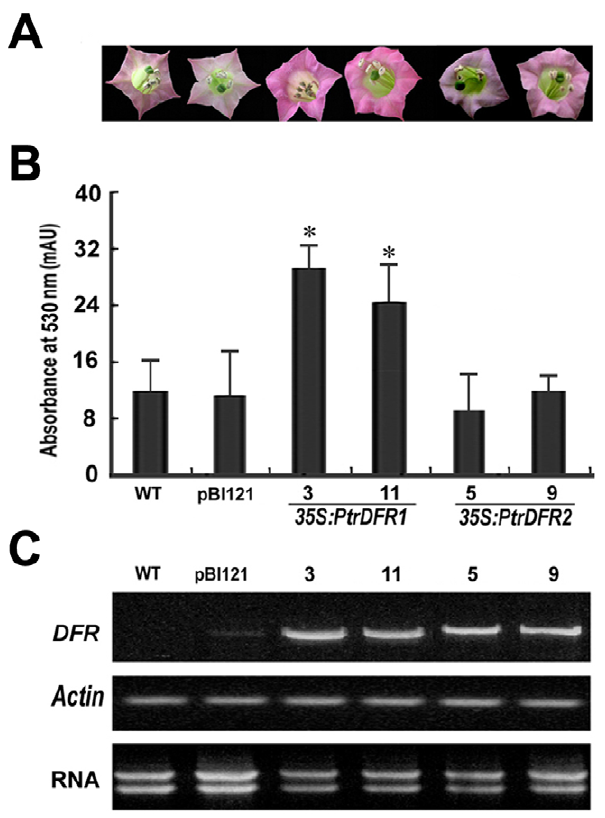
Figure 4. Effect of PtrDFR1 and PtrDFR2invivo on anthocyanin accumulation in transgenic tobacco flowers. ( A ) Overexpression of PtrDFR1 resulted in a visible increase in anthocyanin accumulation in the corolla of transgenic tobacco flowers (lines 3 and 11), relative to untransformed lines (WT) and pBI121 transgenic control (pBI121) or the 35S:PtrDFR2 transgenics (5 and 9). ( B ) Quantitation of anthocyanin levels in transgenic tobacco flowers with a spectrophotometer. Error bars are SDs from three independent experiments. Both the lines harboring the 35S:PtrDFR1 gene had significantly higher anthocyanin levels compared with wild-type and the pBI121 transgenic control (based on a Student’s t test analysis limit of P # 0.05). No lines overexpressing the 35S:PtrDFR2 gene showed significant increases in anthocyanins. ( C ) RT-PCR analysis of PtrDFR1 and PtrDFR2 expression in transgenic tobacco plants.